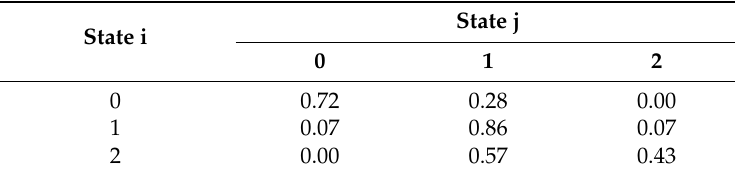
Table 3. Transition probability matrix of the MCFO model leaving the third year out in cross-validation for the month August.